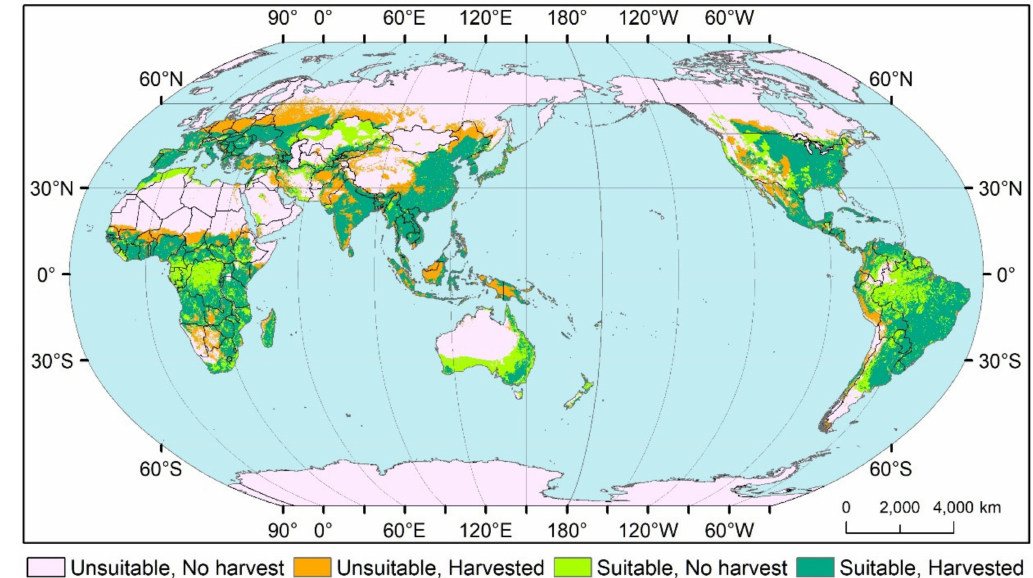
Figure 3. Spatial consistency between areas predicted to be suitable for maize and those on which maize had been grown during the